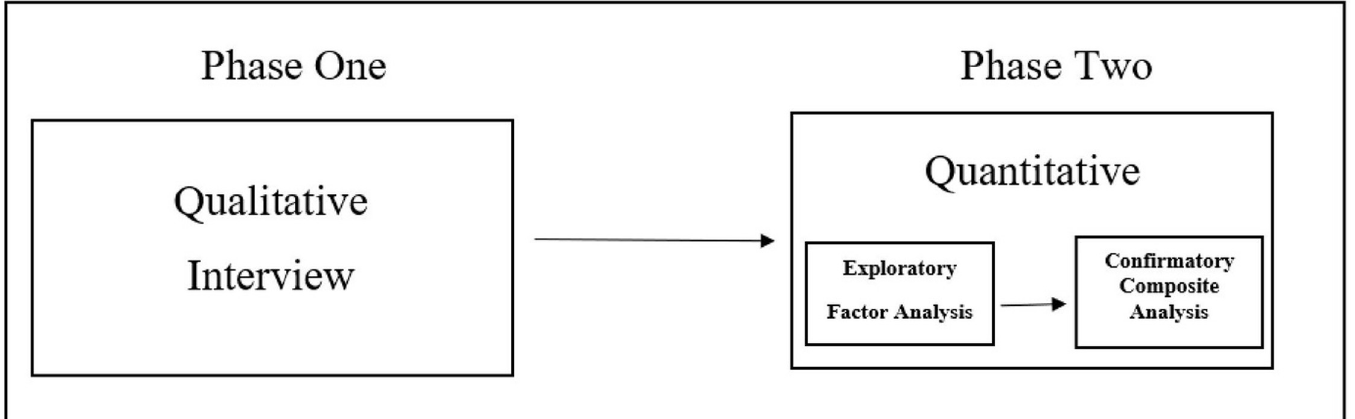
Fig 2. Exploratory mixed methods research design employed in this